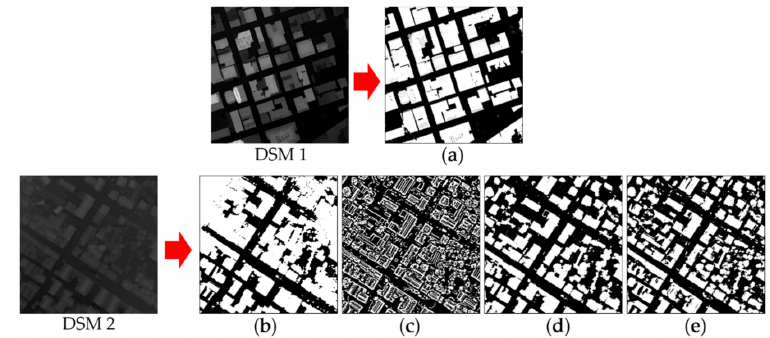
Figure 2. Comparison of different threshold segmentation results (subsets of original DSM, pixel size of DSM2 is 1500 × 4000). ( a ) Based on global threshold of 10; ( b ) based on global threshold of 40; ( c ) based on an adaptive threshold with N = 25 and C = 0; ( d ) based on an adaptive threshold with N = 165 and C = 0; ( e ) based on an adaptive threshold with N = 85 and C =